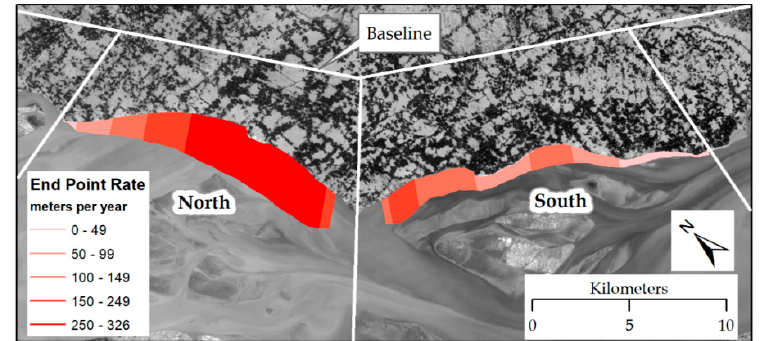
Figure 6. Shoreline change rate map—End Point Rate, positive indicates erosion.